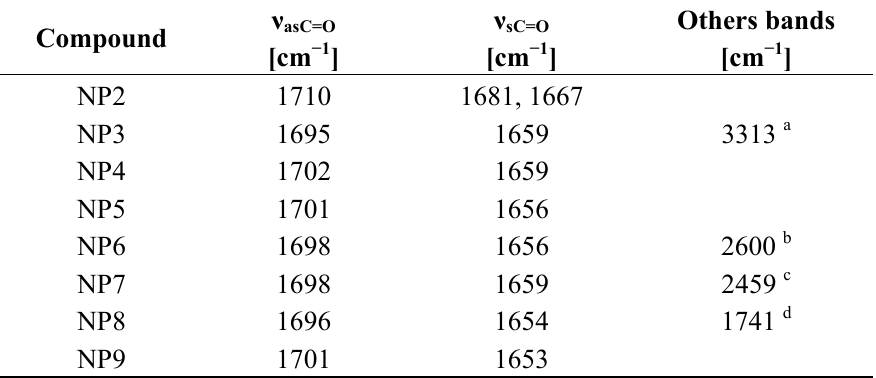
Table 1. Selected FTIR frequencies for naphthalimide derivatives.